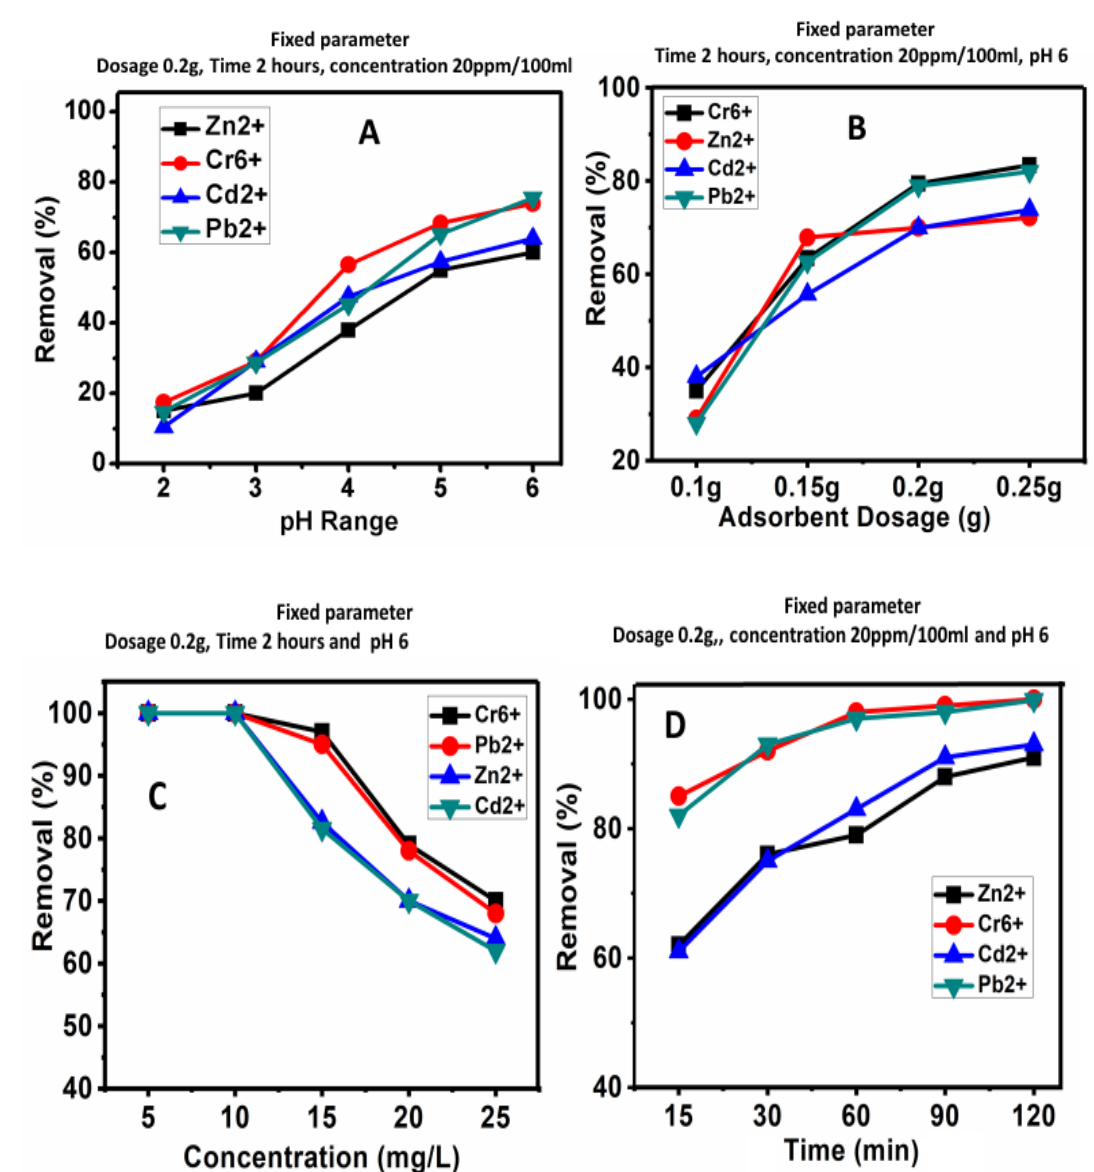
Figure 3. The effect of pH ( A ), adsorbent dosage ( B ), metal ions concentration ( C ) and contact time ( D ) on the adsorption process of the metal ions on the AC.